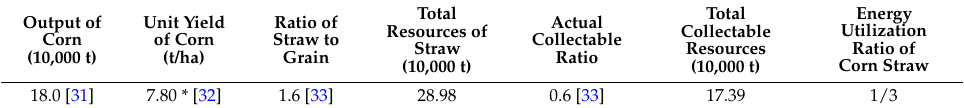
Table 1. Data of corn straw energy utilization resources assessment in the case